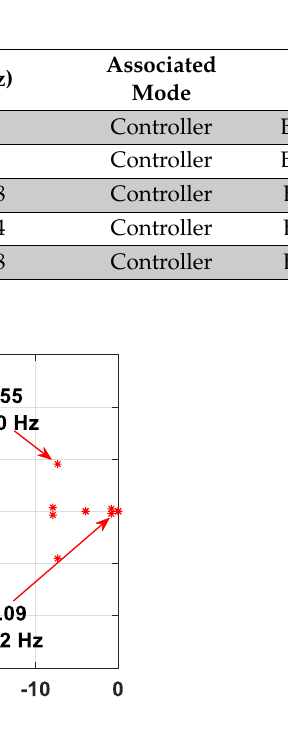
Figure 3. Frequency response of the system: ( a ) Output and input impedance; ( b ) total impedance seen from DC link.